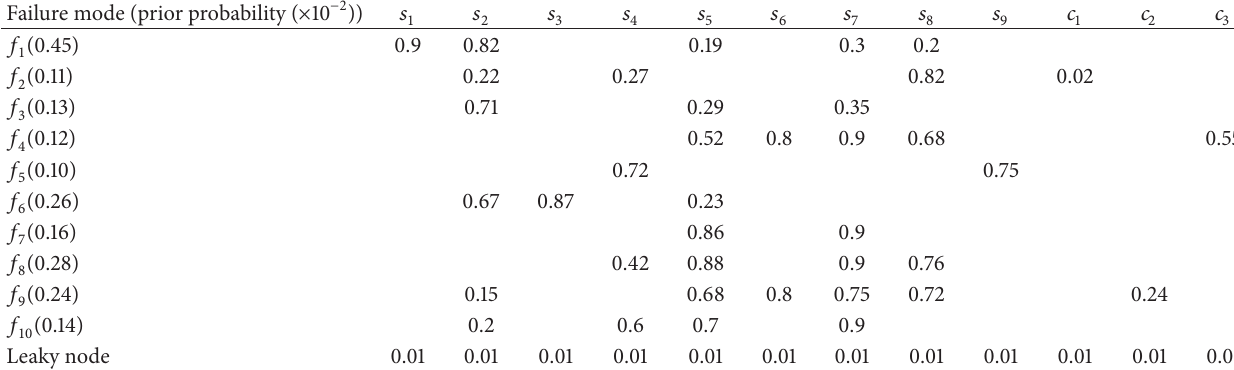
Table 2: Parameters of integrated fault diagnosis model.